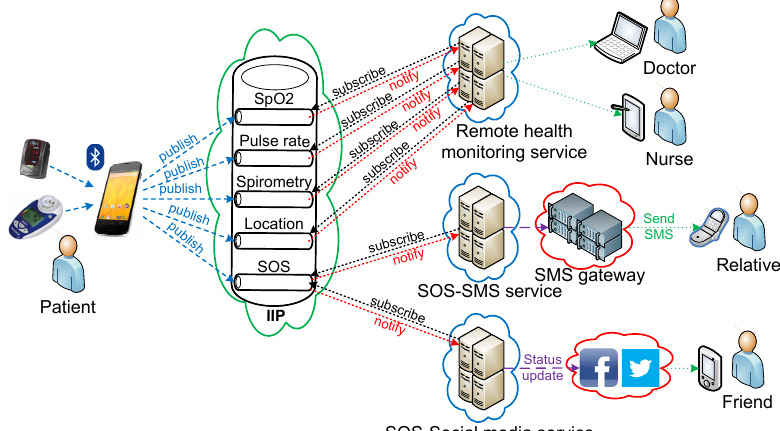
Figure 10. End-to-end perspective of implemented service